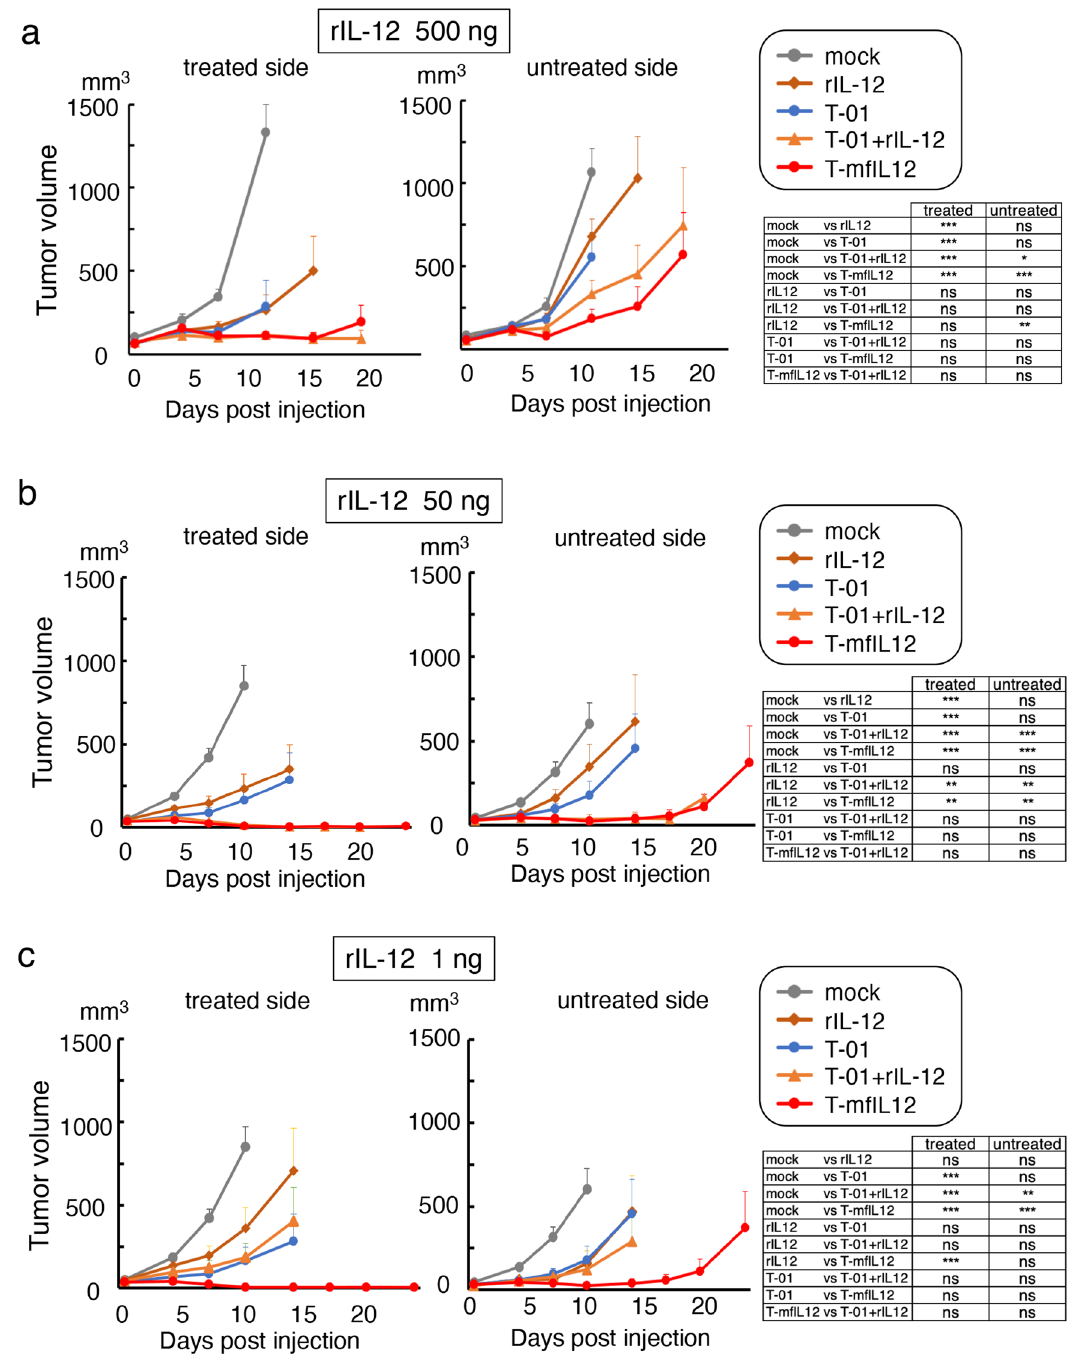
Fig. 6 Comparison of in vivo ef fi cacy of T-mfIL12 and direct intratumoral injection with recombinant interleukin-12 (rIL-12). In the bilateral subcutaneous Neuro2a model, rIL-12, T-01 (5 × 10 4 pfu) without or with rIL-12, T-mfIL12 (5 × 10 4 pfu) or mock was inoculated into the left tumors only on days 0 and 4 (n = 10 per group). Three different doses were used for rIL-12; 500 ng ( a ), 50 ng ( b ) and 1 ng ( c ). The dose 50 ng represents the intratumoal IL-12 level treated with T-mfIL12 at 2 × 10 6 pfu and 1 ng represents that at 5 × 10 4 pfu, the T-mfIL12 dose used in these experiments. a When the dose of 500 ng was used for rIL-12, rIL-12, T-01, T-01 + rIL-12 and T-mfIL12 were all signi fi cantly more ef fi cacious than mock in the treated side ( p < 0.001 vs mock for all). In the untreated side, rIL-12 alone showed no signi fi cant antitumor effect compared with mock, whereas T-01 + rIL-12 and T-mfIL12 showed a signi fi cantly higher ef fi cacy than mock ( p = 0.039 and p < 0.001 vs mock, respectively). Further, in the untreated side, T-mfIL12, but not T-01 + rIL-12, was signi fi cantly more ef fi cacious than rIL-12 alone ( p = 0.003). b Results similar to a were obtained when the dose of 50 ng was used for rIL-12. c When the dose of 1 ng was used for rIL-12, rIL-12 alone showed no signi fi cant ef fi cacy in both treated and untreated sides, and T-mfIL12, but not T-01 + rIL-12, was signi fi cantly more ef fi cacious than rIL-12 alone in the treated side. Tumor volume = length × width × height × 0.52. Results represent the mean. Bars, standard error of the mean (SEM). *, p < 0.05; **, p < 0.01; ***, p < 0.001; ns, not signi fi cant; Two-way ANOVA with Bonferroni ’ s multiple comparisons